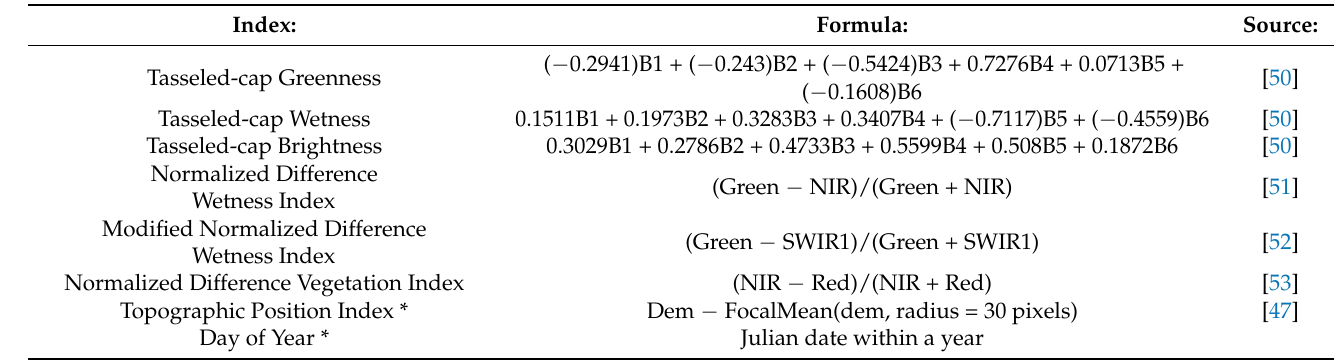
Table 1. Spectral indices used in the SWF algorithm. These indices include those originally suggested by De Vries et al. [45], and those proposed here for use with LandTrendr (identified with an asterisk). These indices were used to train a random forest model in the SWF algorithm to identify percent surface water within a